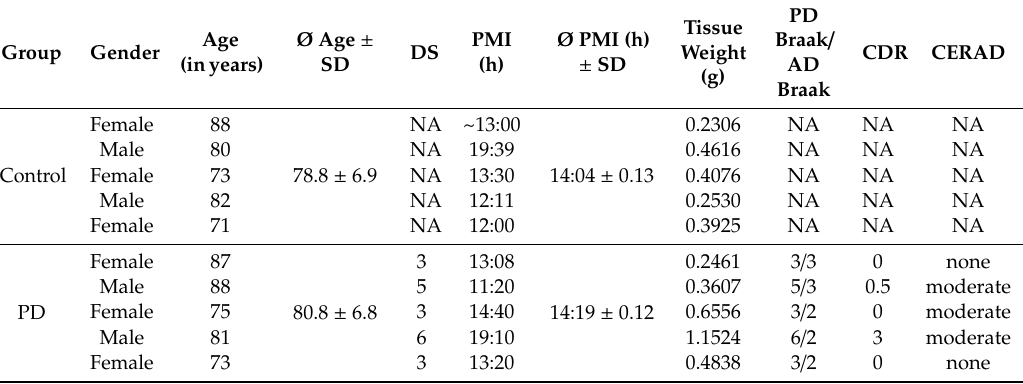
Table 1. Characteristics of the study